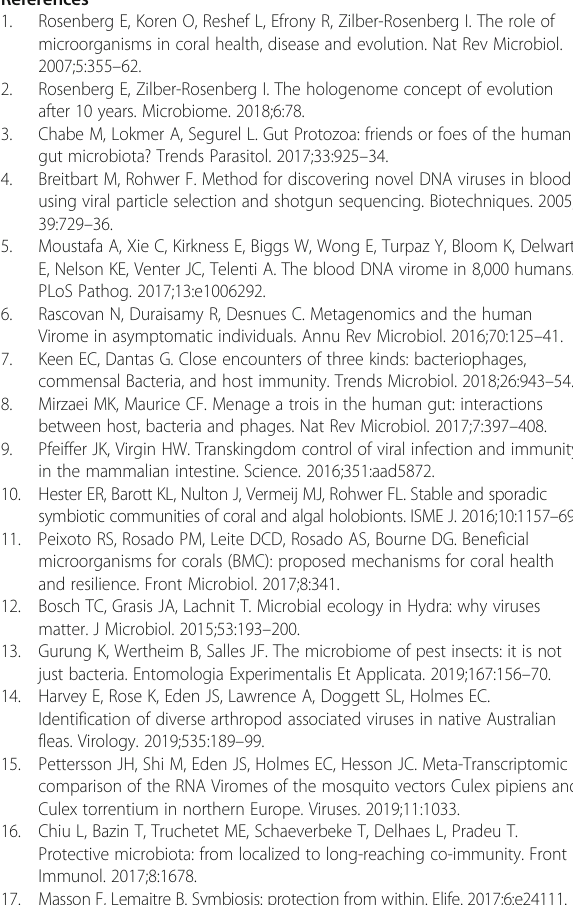
Additional file 9: Table S8. Generalized least squares by maximum likelihood linear models testing for differences in alpha diversity between the families in the hatchery. Additional file 10: Table S9. Permanova based on Bray-Curtis dissimi- larities testing for differences in beta diversity between the families in the hatchery. Additional file 11: Table S10. Linear mixed-effects models testing for effects of the environment, genitors ’ origin, selection pressure and their interactions on alpha diversity. Additional file 12: Table S11. Permanova based on Bray-Curtis dissimi- larities testing for effects of the environment, genitors ’ origin and selec- tion pressure and their interactions on beta diversity. Additional file 13: Table 12. Permanova based on Bray-Curtis dissimi- larities testing for differences in beta diversity between the families in the infectious